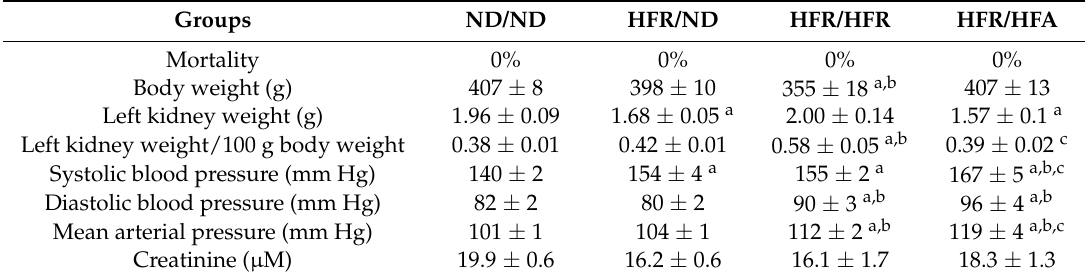
maternal high-fructose intake and post-weaning high-fat diet at 12 weeks of age. Groups